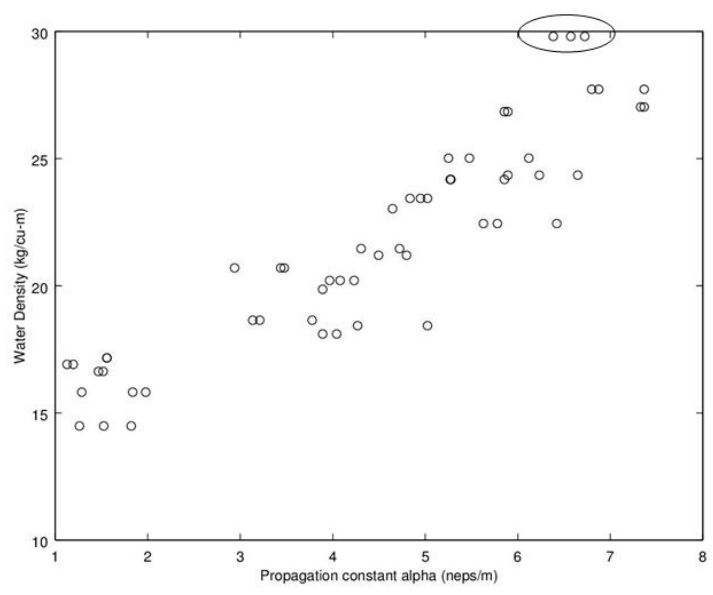
Figure 16. Graph detailing propagation attenuation constant, α , versus bulk water density at 2.5 GHz. Of interest is that as the frequency is moving still higher; the very wet low-density module samples are inverted and are again moving apart. The points associated with the excessively wet low-density module are circled. Note water density calculated from moisture content utilizing Equation (9).